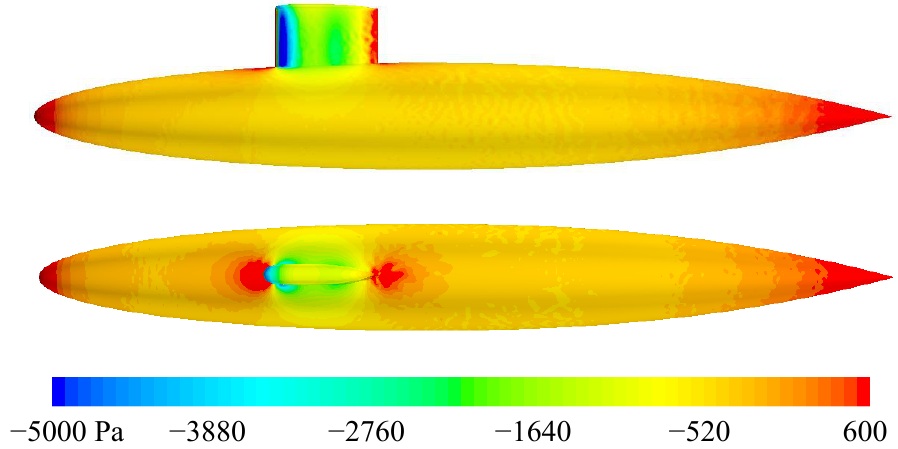
Figure 9. Simulation results of surface pressure on underwater vehicle with sail.